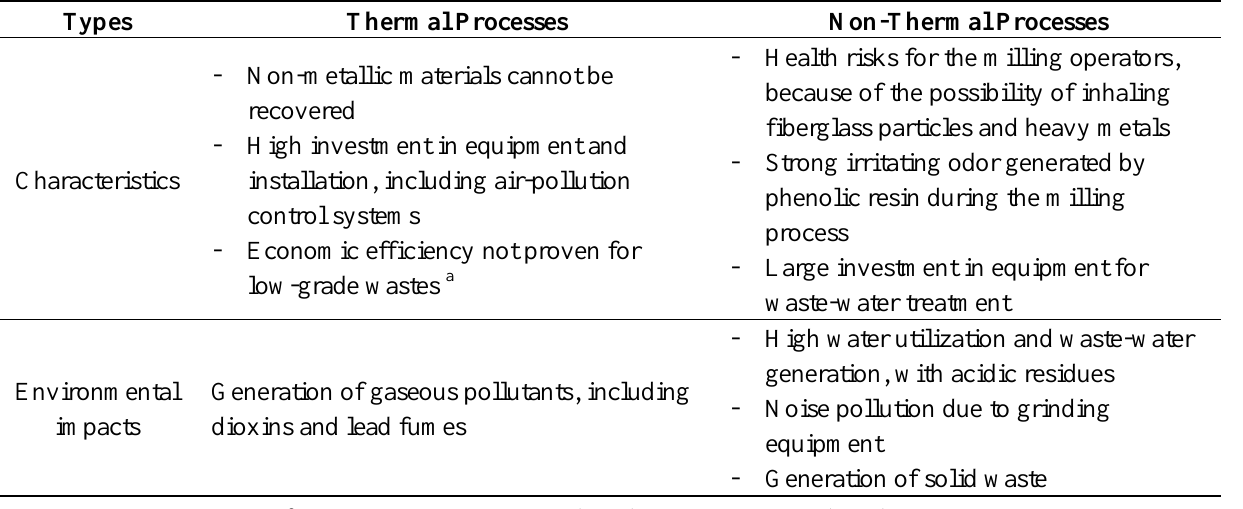
Table 1. Comparison of the main processes for recovering metals from printed circuit boards